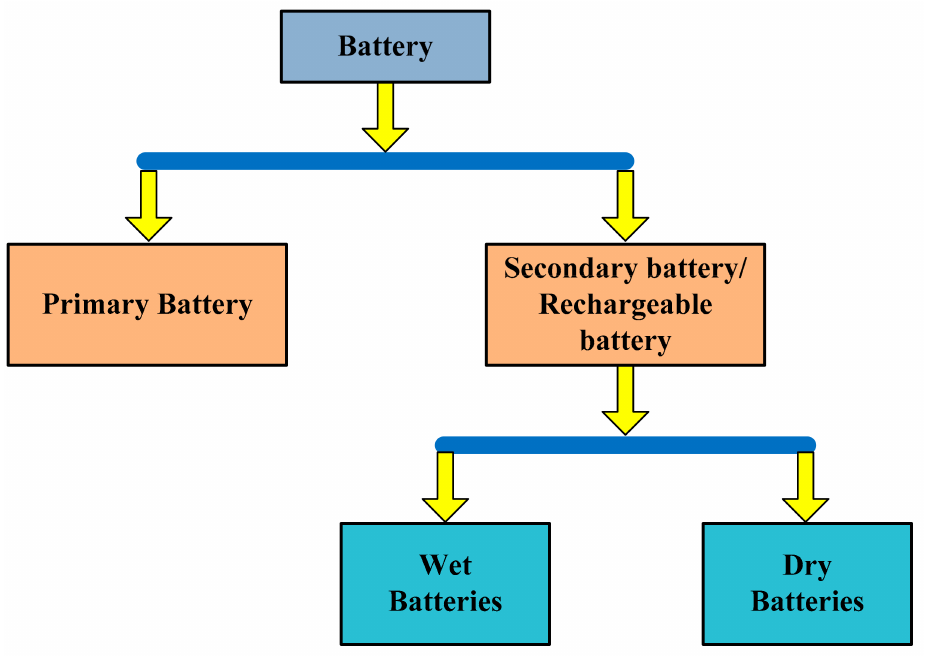
Figure 4. Different types of batteries.